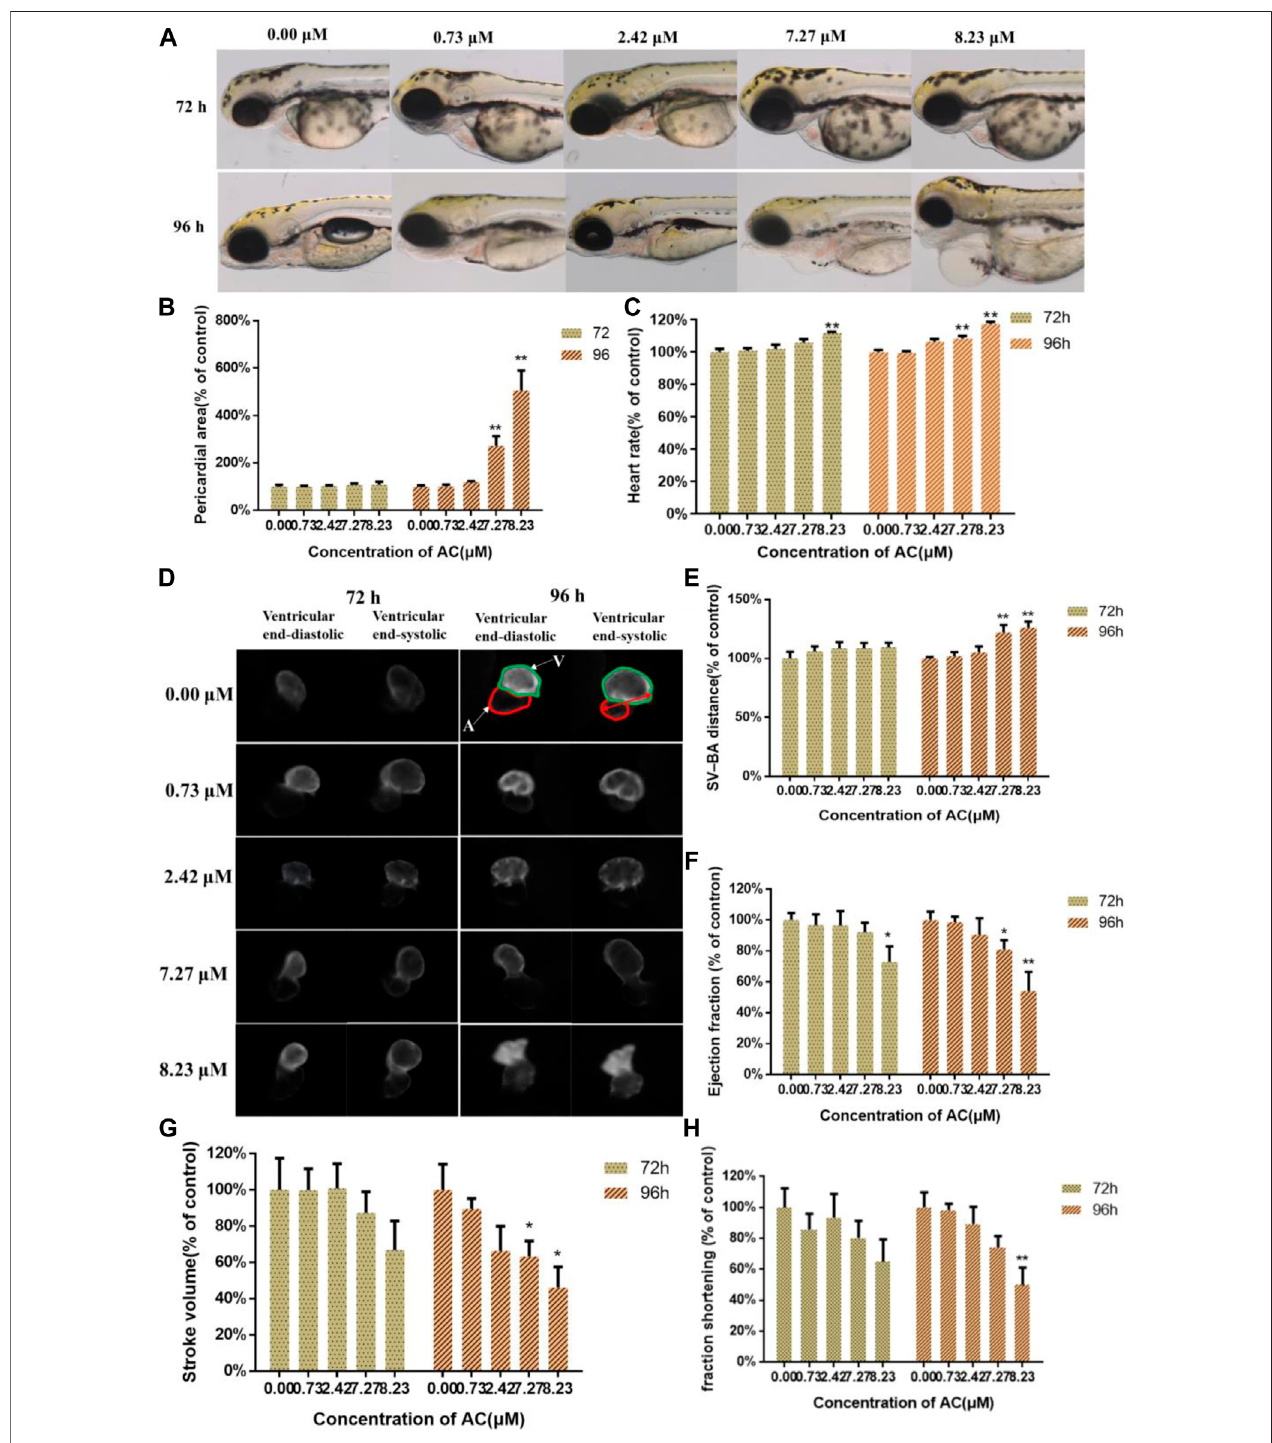
FIGURE 2 | Effects of AC on developing heart. (A) Bright- fi eld images of the Tg(myl7:EGFP) zebra fi sh embryos at 72 and 96 hpf. A, atrium; V, ventricle. The red double-headed arrow represents SV-BA distance. (B) Pericardial area of embryos at 72 and 96 hpf. (C) The heart rate of embryos at 72 and 96 hpf. (D) The images of ventricular end-diastolic and end-systolic at 72 and 96 hpf. (E) SV-BA distance of embryos at 72 and 96 hpf. (F) Ejection fraction of embryos at 72 and 96 hpf. (G) The stroke volume of embryos at 72 and 96 hpf. (H) Fraction shortening of embryos at 72 and 96 hpf. The values are expressed as mean ± SD ( n (cid:1) 10). * p < 0.05 and ** p < 0.01 vs.